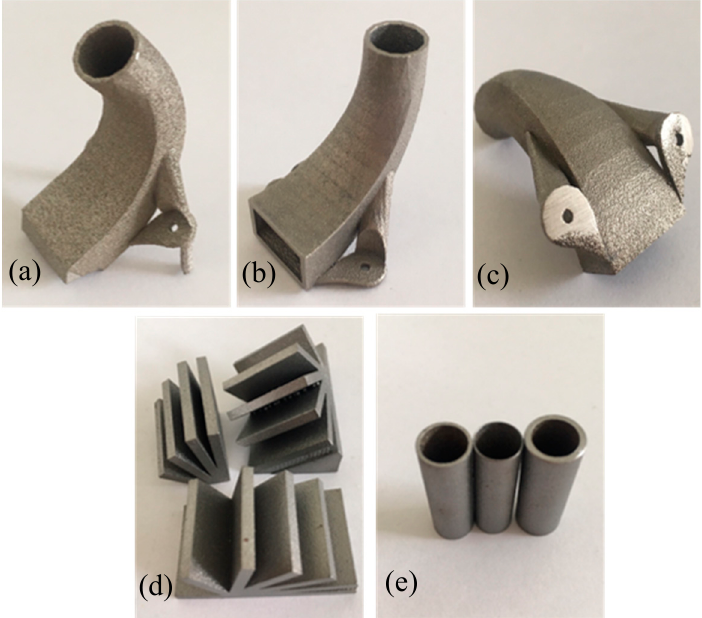
Figure 6. ( a ) Flow connector with support structures; ( b ) flow connector without support structures; ( c ) flow connector underside; after the removal of a 1 mm layer of material, the surface defects persisted; ( d ) separation between outlets should be larger than 30° to avoid the generation of defects among the outlets; ( e ) no manufacturing defects were observed in the pipe-like test artifacts.